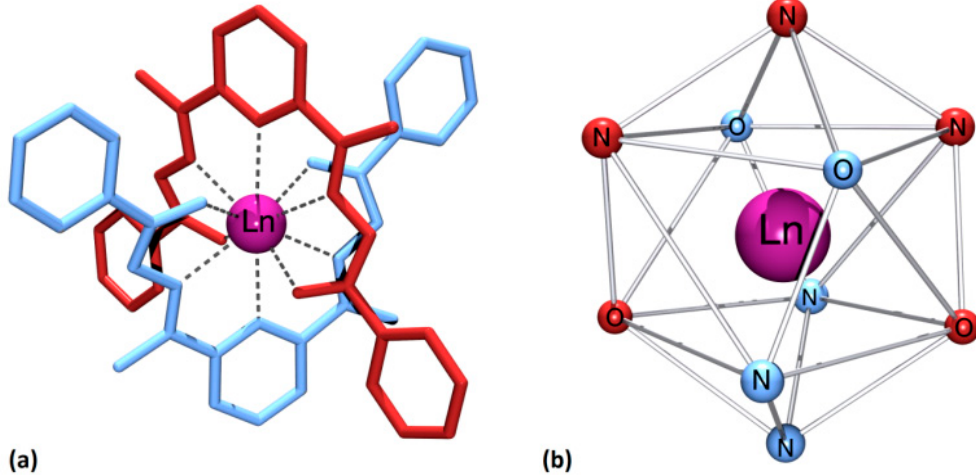
Figure 3. Schematic representation of ( a ) the coordination of two pentadentate ligands on an Ln atom to form a complex [Ln(HL)(L)] and ( b ) bicapped square antiprism LnN 6 O 4 capped by the pyridyl N atoms of the H 2 DAPBH ligand.